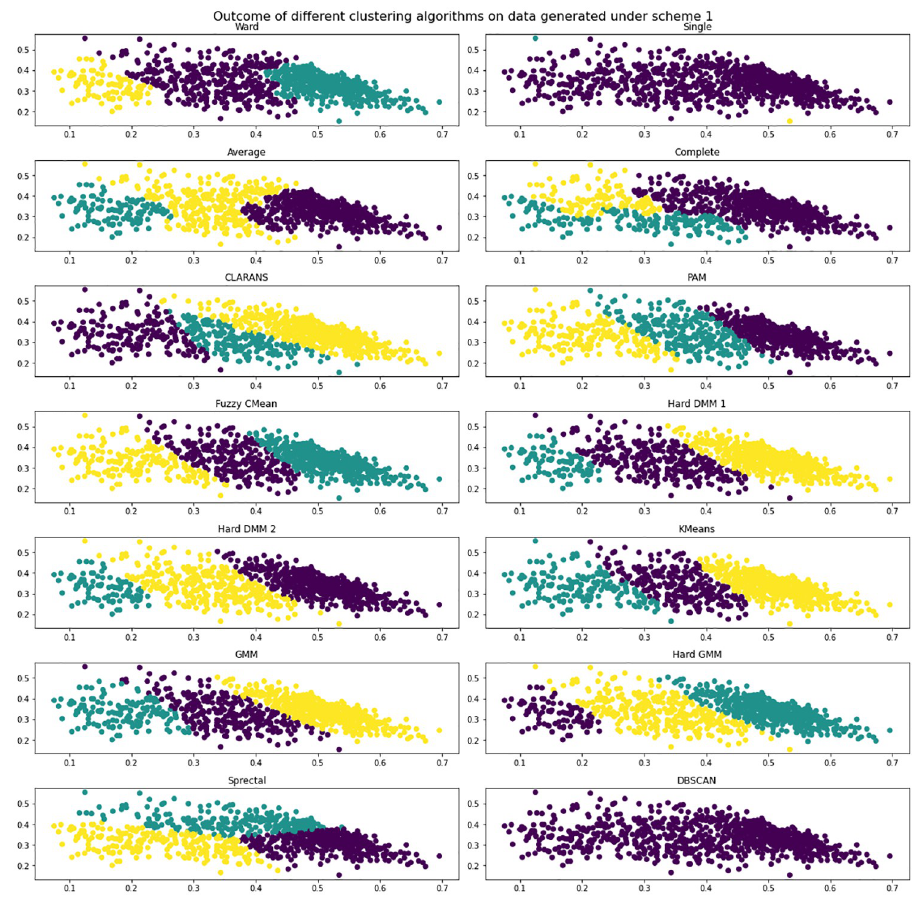
Fig 2. Outcome of different clustering algorithms on simulated data generated under scheme 1.